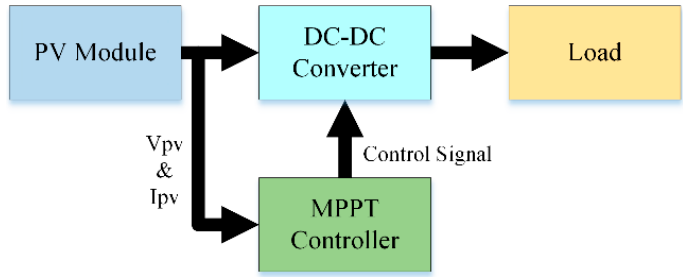
Figure 3. Block diagram of PV-MPPT governing system.